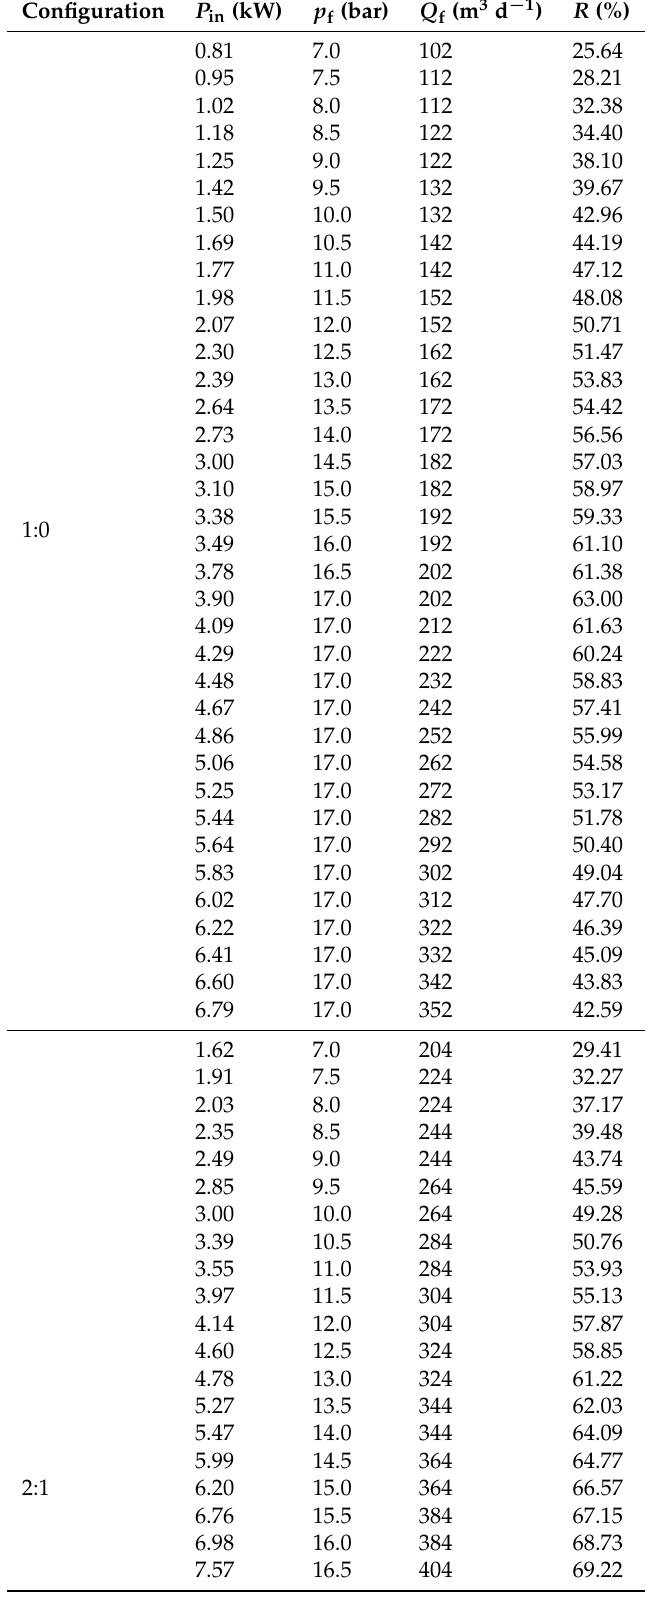
Table A3. P in , p f , Q f and R for maximizing Q p considering three different BWRO configurations and using sample 11 (Table 1) as